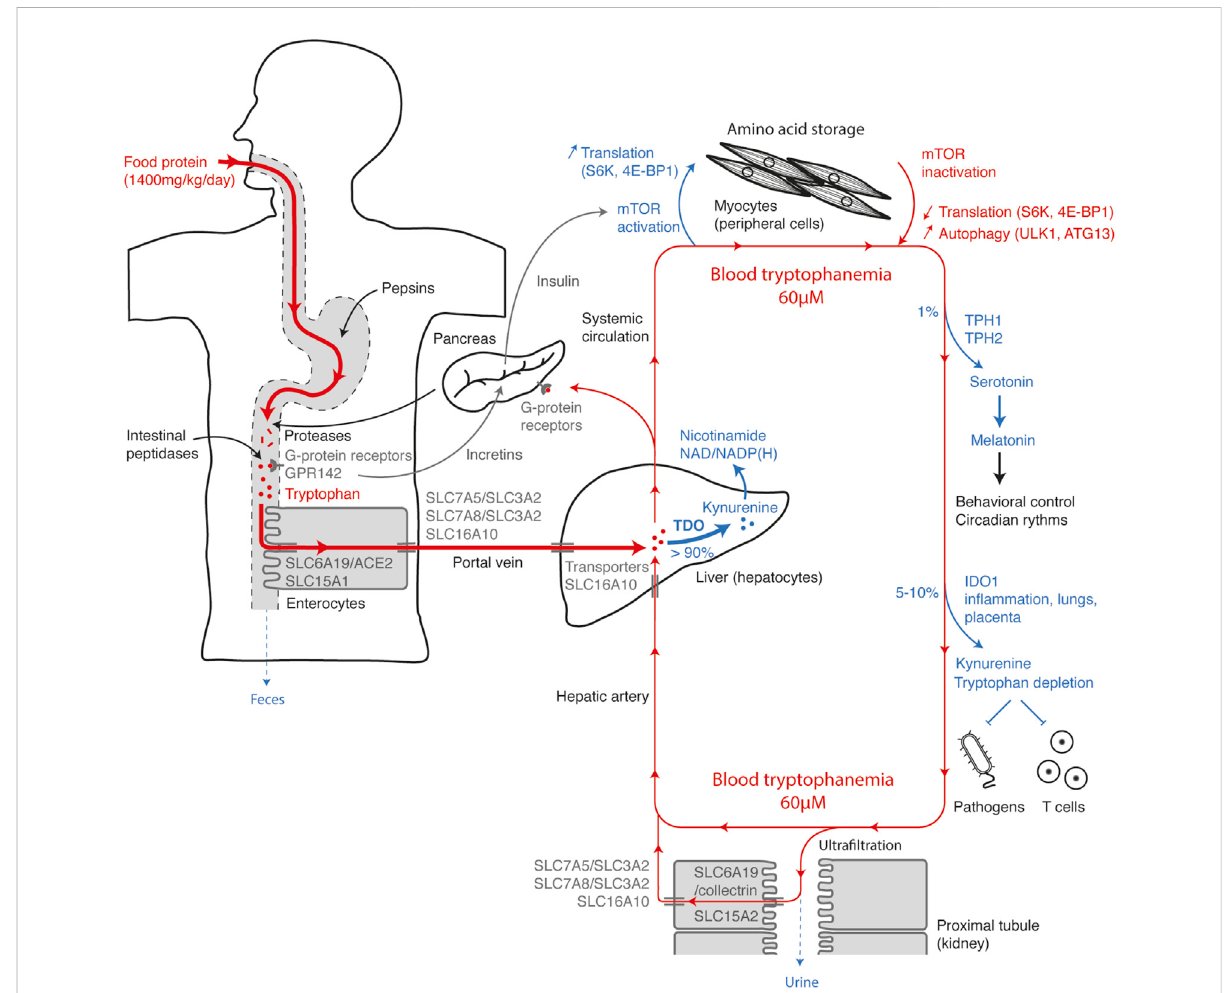
FIGURE 8 Tryptophanhomeostasisoverview.The fi gurerepresentsthemaincheckpointsoftryptophanhomeostasisfromfoodintaketoelimination.The stepsincreasingthesystemicconcentrationoftryptophanaredepictedinredandthestepsdecreasingtryptophan,inblue.Entryoftryptophaninthe systemiccirculationis fi rstconditionedbyintestinalabsorptionthroughpolarized cells(leftside), optimized togetamaximumofdietary tryptophan. Once absorbed, the tryptophan contained in the portal vein is fi ltered by the liver and mainly metabolized by TDO (center), before entering in the systemic circulation. High amino-acid levels and postprandial hormones activate the mTOR pathway in muscles and peripheral tissues (top), stimulating protein synthesis and amino-acid storage. When amino-acid levels are low, inactivation of mTOR slows down translation and induces proteinautophagy,whichcontributestoamino-acidsavingandrelease.AsmallpercentageoftryptophanismetabolizedinserotoninbyTPH1/2and in kynurenine by IDO1 in peripheral tissues (right side). Almost all the tryptophan present in the glomerular ultra fi ltrate is actively reabsorbed by polarized cells of the proximal renal tubules (bottom). Excess circulating tryptophan is fi ltered by hepatocytes and degraded by TDO